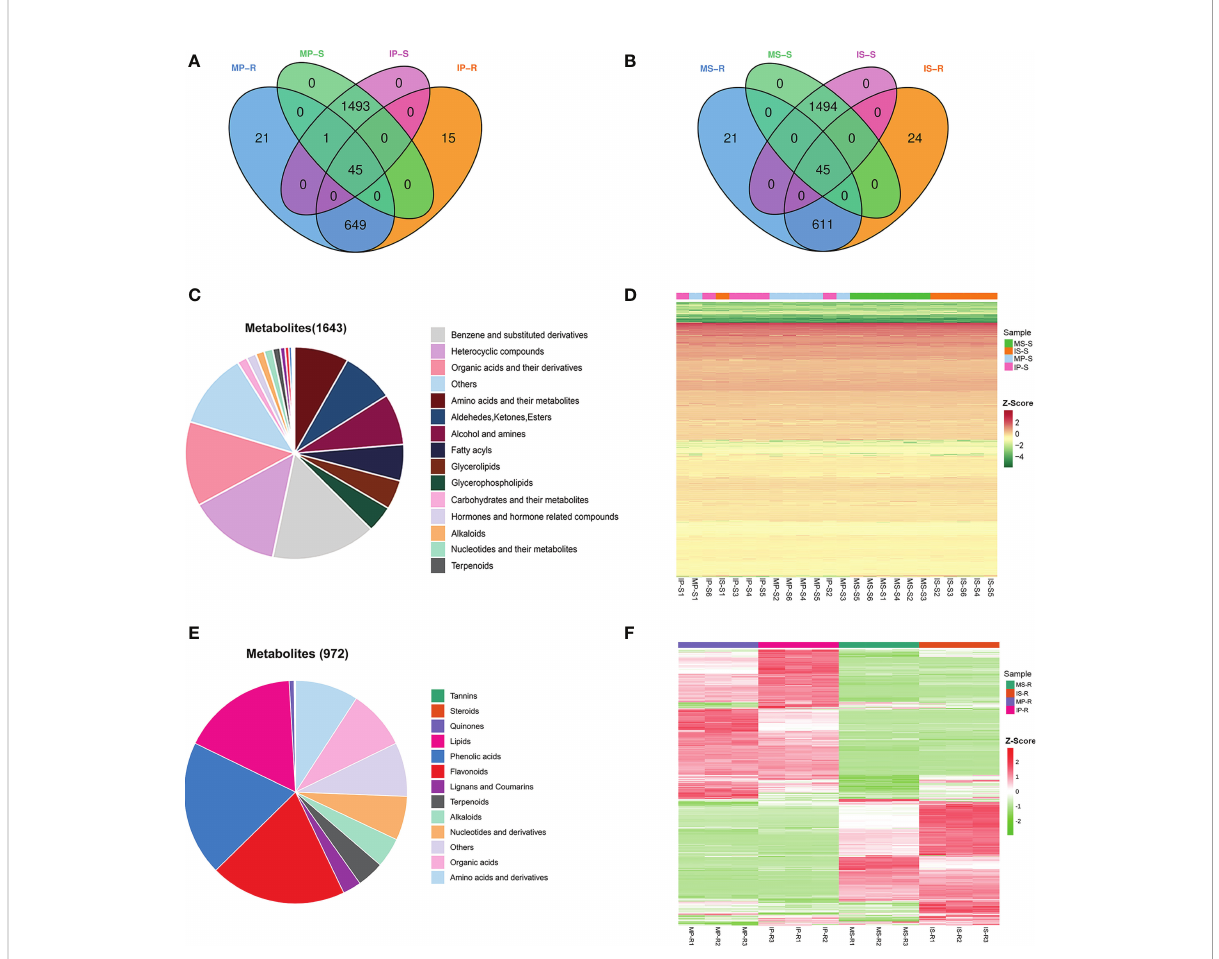
FIGURE 3 Variability of 972 and 1643 diverse metabolites in the roots and their rhizosphere soils. (A) Venn diagram of the root and rhizosphere soil metabolites in monoculture peanut and intercropping peanut; (B) venn diagram of root and rhizosphere soil metabolites in monoculture sugarcane and intercropping sugarcane; (C) classi fi cation of the 1643 identi fi ed metabolites in the rhizosphere soils; (D) heatmaps of metabolites from rhizosphere soil compared between different groups; (E) classi fi cation of the 972 identi fi ed metabolites in the roots; (F) heatmaps of metabolites from roots compared between different groups. Six biological replicates were used to detect the metabolites of MP-S, MS-S, IP-S and IS-S, and three biological replicates were used to detect the metabolites of MP-R, MS-R, IP-R and